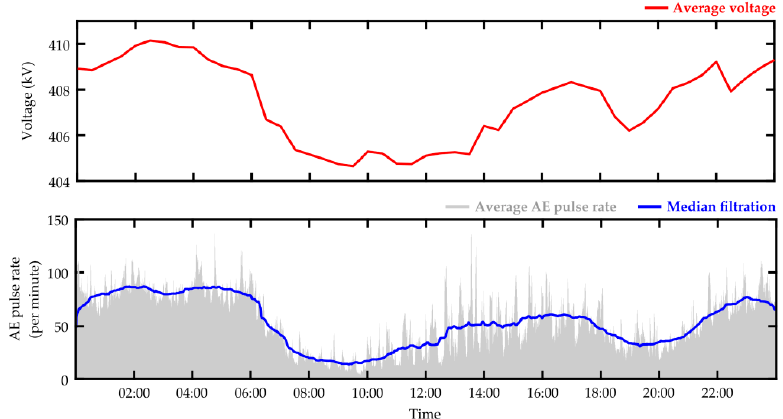
Figure 2. Daily distribution of average voltage values and average AE pulse rate obtained from 30 days of monitoring of a 330 MVA power transformer.